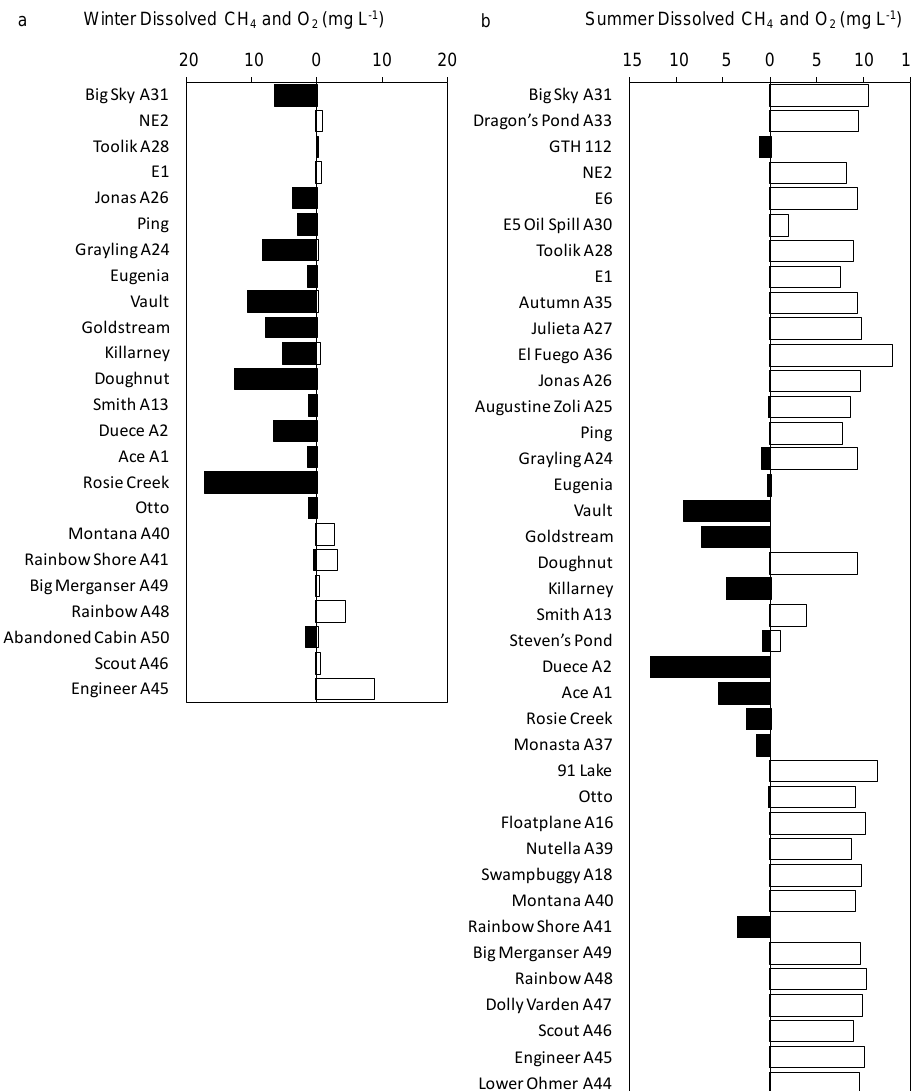
Figure 5. Average dissolved CH 4 (black bars) and O 2 (white bars) concentrations in lake bottom water during winter (a) and summer (b) . Yedoma lakes are indicated by “Y”. In winter, a Spearman coefficient of r s = 0 . 58 indicates a moderate positive correlation between dissolved CH 4 and O 2 ; in summer r s = 0 . 70 indicates a strong positive